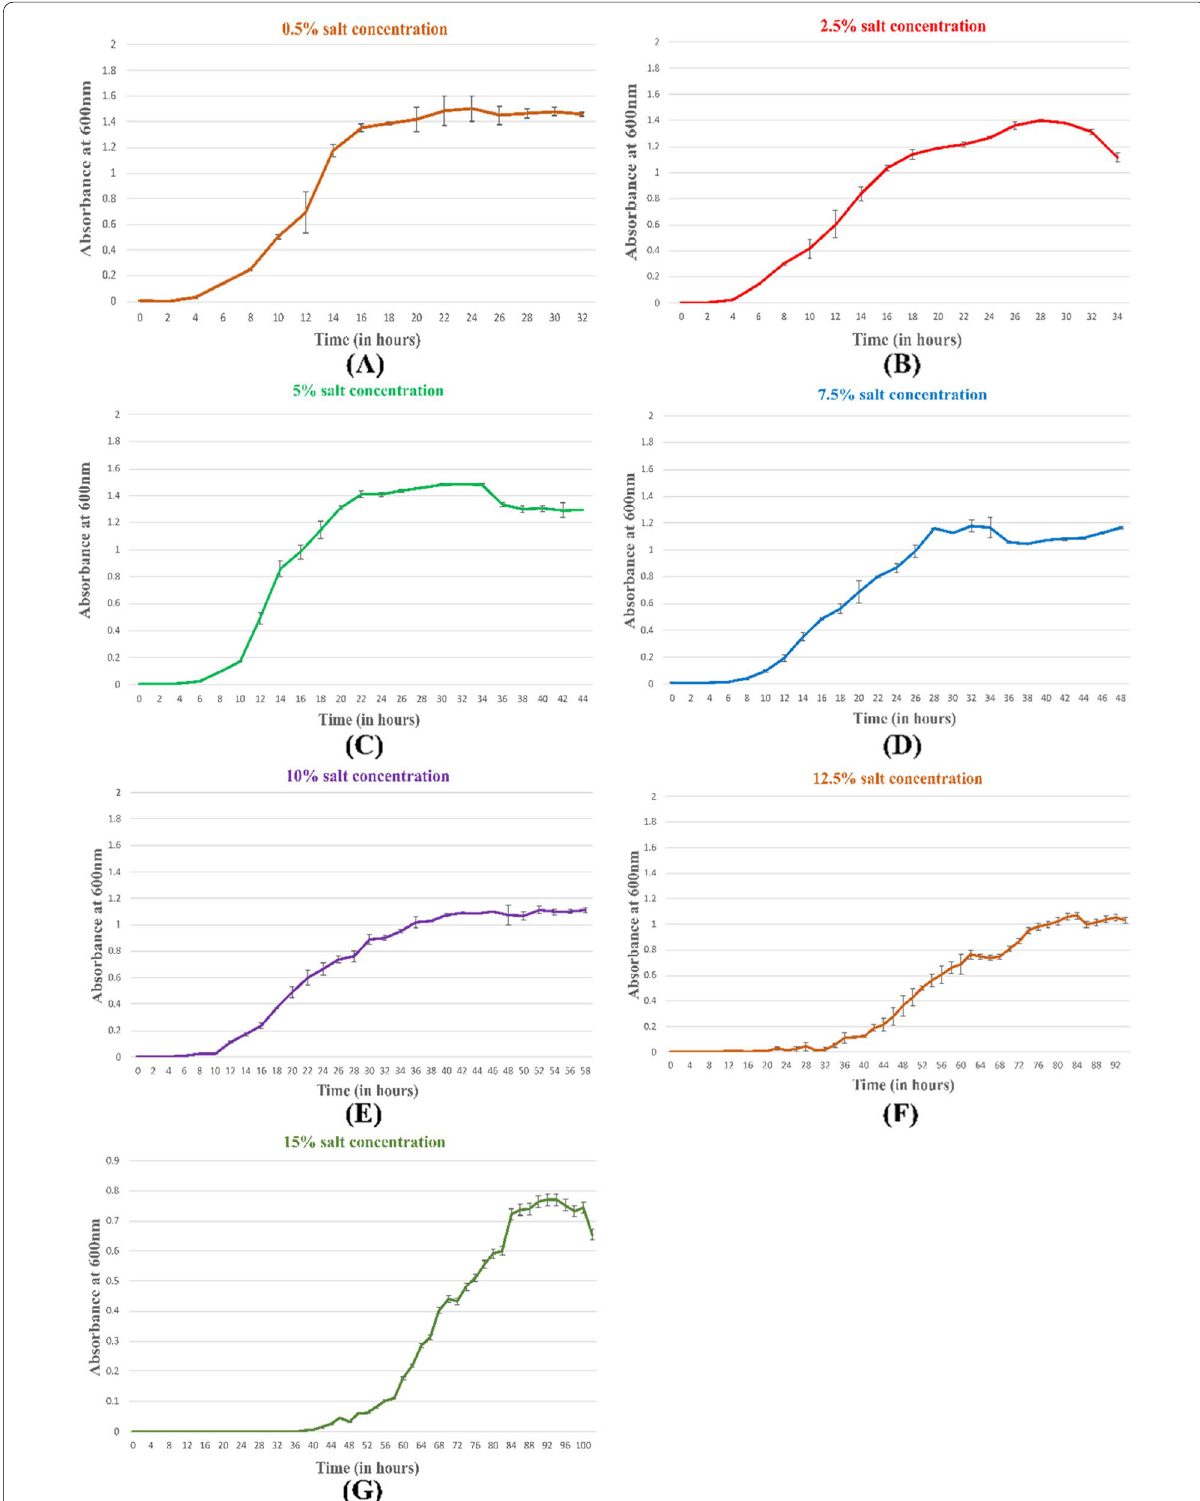
Fig. 2 Effect of varying NaCl concentrations on growth of MHN12 grown in TSB incubated at 28